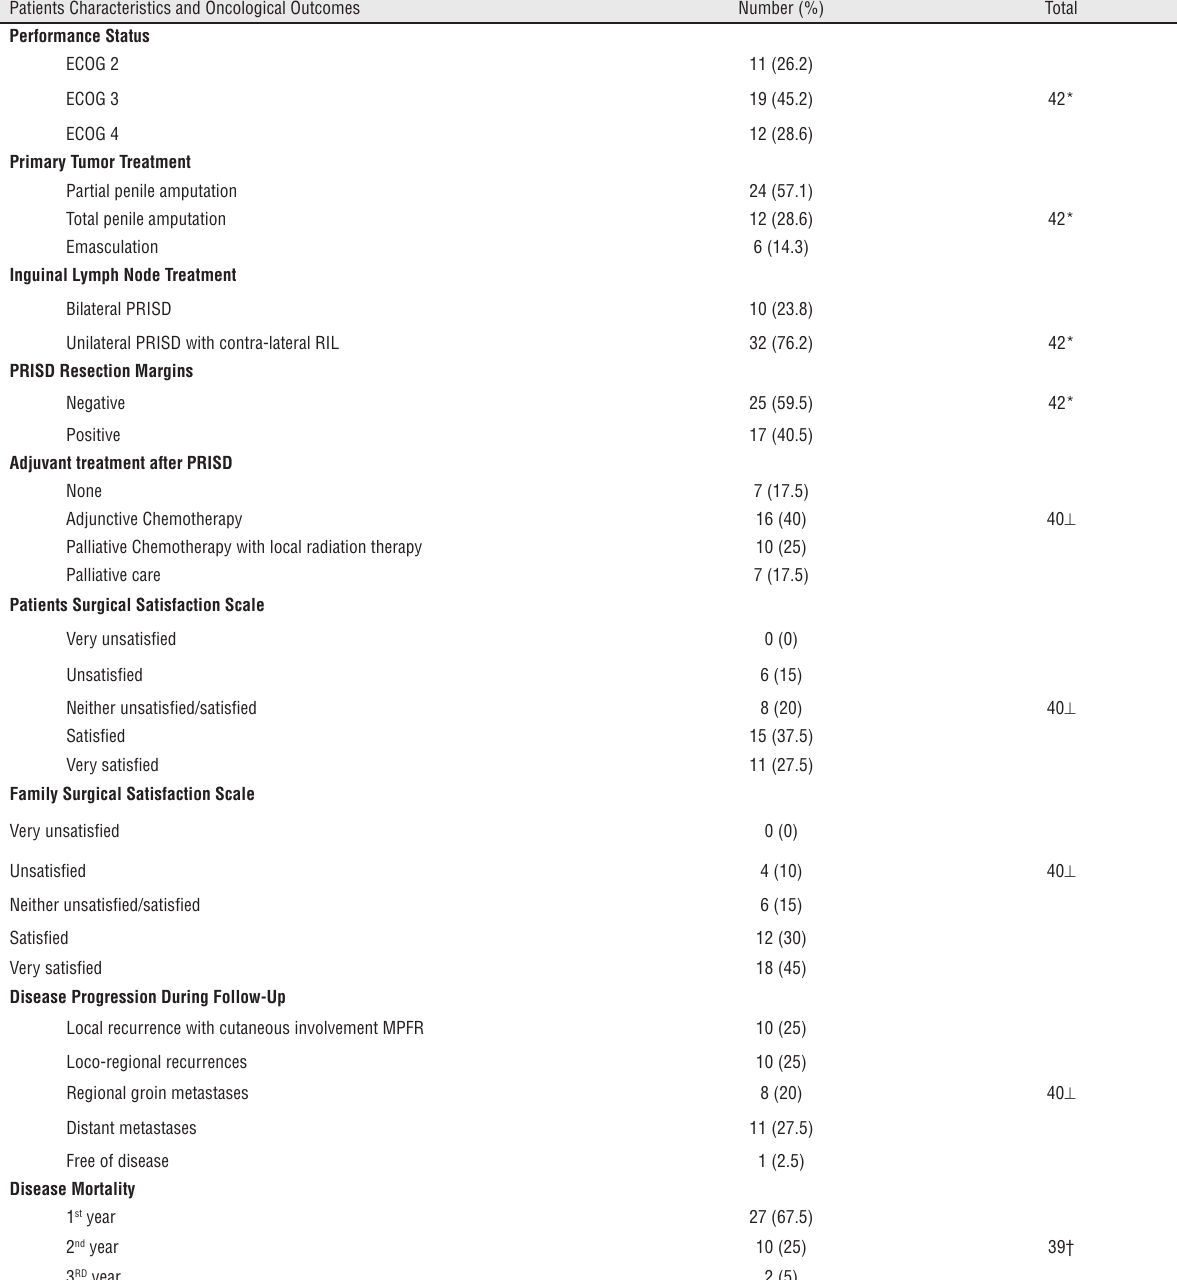
Table 3. -Patient’s characteristics and oncological outcomes in 42 patients undergoing PRISD for locally advanced penile